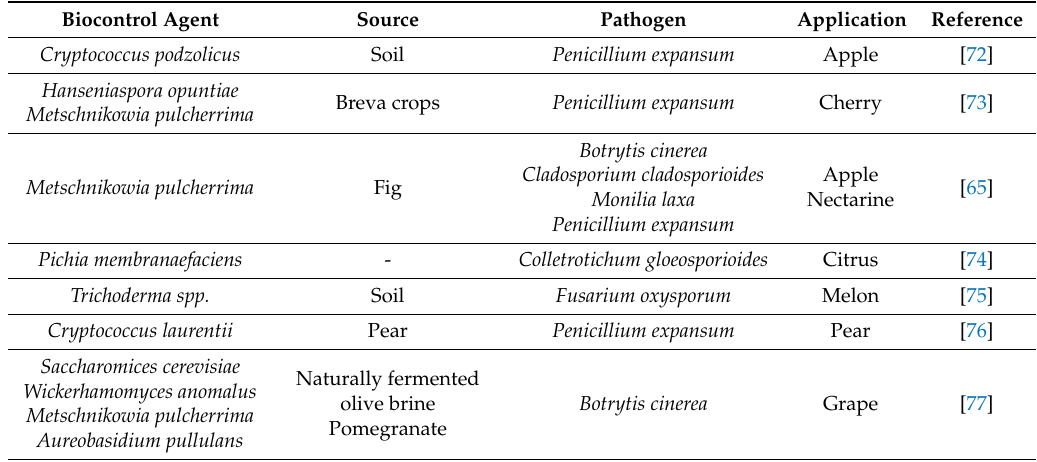
Table 7. Representative antagonistic fungi and yeasts used as biocontrol agents for the preservation of